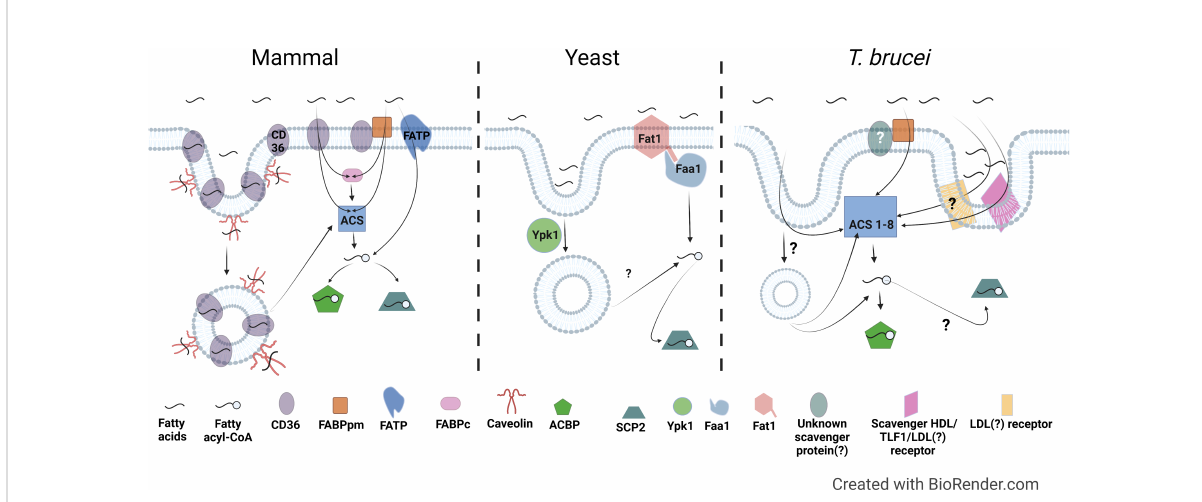
FIGURE 2 Comparison of fatty acid uptake machinery in mammals, yeast, and T. brucei. Left, Mammal: In mammals, the membrane proteins CD36, FABPpm, FATP are involved in fatty acid uptake either individually or in combination. CD36 and Caveolin are also involved in endocytosis mediated fatty acid uptake. CD36, Cluster of Differentiation 36; FABPpm, Plasma membrane associated fatty acid binding protein; FATP, Fatty acid transport protein; FABPc, Cytosolic fatty acid binding protein; ACS, Acyl-CoA Synthetase; ACBP, Acyl-CoA binding protein; SCP2, Sterol carrier protein 2. Middle, Yeast: Fat1, the ortholog of mammalian fatty acid transport proteins in yeast, is involved in fatty acid uptake. Faa1, which is a yeast ACS, activates the fatty acids by converting to fatty acyl-CoA. Ypk1, the yeast ortholog of the human serum- and glucocorticoid-induced kinase is involved in fatty acid uptake via endocytosis. Right, T. brucei : T. brucei possesses homologs to FABPpm, but presence or identity of FABPpm interacting partners is unknown yet. There is evidence of involvement of a scavenger receptor in uptake of HDL, LDL, and Trypanosome lytic factor 1 (TLF1) (Green et al., 2003), however, it is not clear if it is the same or different LDL receptor previously described by Coppens et al. (Coppens et al., 1992). Proteins involved in fatty acid uptake via endocytosis have not been identi fi ed yet. T. brucei genome encodes for 8 ACSs, which probably have different speci fi cities to activate fatty acids of varying lengths and in different sub- cellular